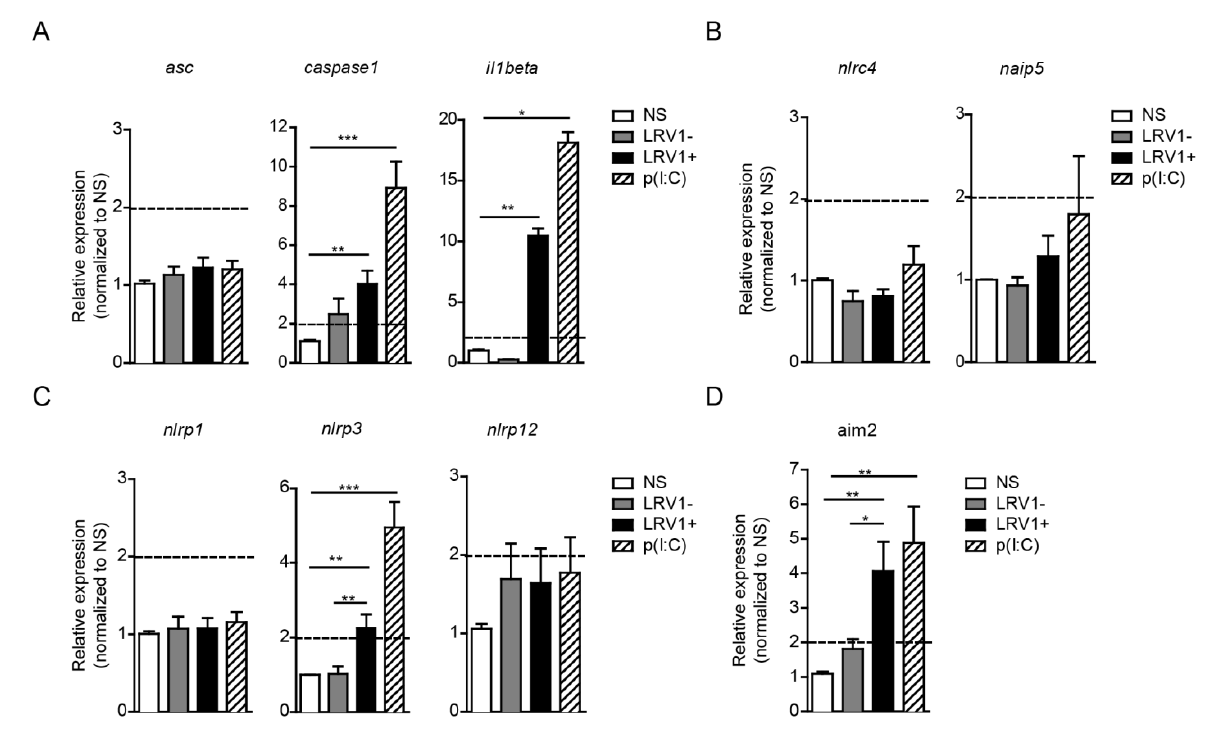
FIGURE 2: LRV1 promotes the transcription of the inflammasome components, caspase-1, IL-1β, NLRP3 and AIM2. BMDMs from C57BL/6 mice were infected with LgyLRV1+ or LgyLRV1- parasites or stimulated with a synthetic TLR3 ligand, poly(I:C). After 6 hours and 12 hours, mRNA was quantified by qRT-PCR. (A) The common inflammasome components ASC, Caspase-1 and IL-1β and the inflammasome-forming members of the (B) NLRC family, (C) NLRP family and (D) a non-NLR inflammasome-forming molecule, AIM2 were measured. Levels are representative of both 6-hour and 12-hour time points. Representative results are shown from at least three independent experiments, using two technical and two biological replicates, and showed as mean ± SEM. Non-parametric Student’s t-test is shown. *p < 0.05, **p < 0.01, ***p < 0.001. A cut off value of 2-fold was used as a limit of significance and is indicated as a dotted